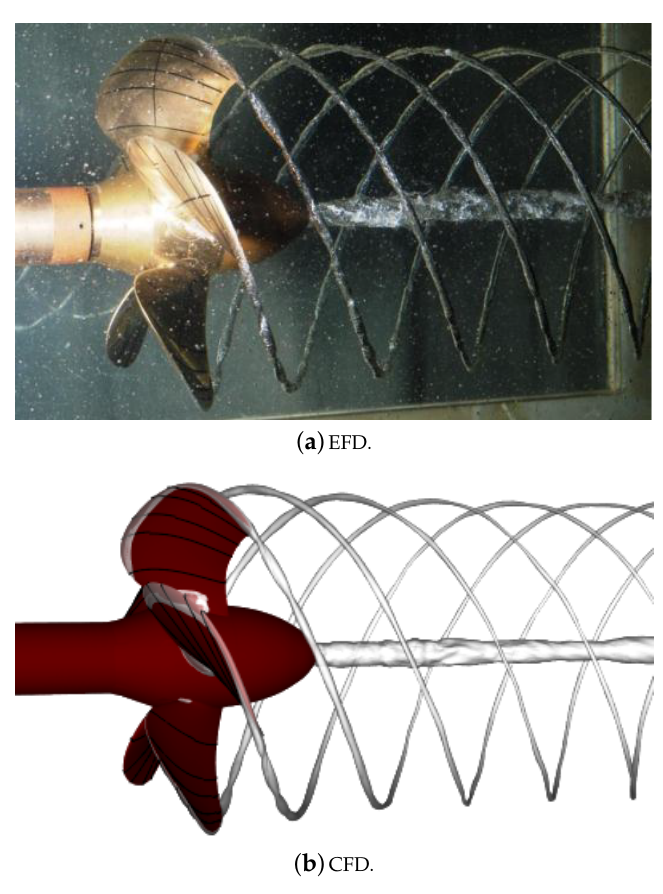
Figure 13. Comparison of the tip and hub vortex cavitation extents behind the propeller. The surface restricted streamlines and pressure coefficients, C p = 2 ( p − p ∞ ) / ( ρ ∞ n 2 D 2 ) , on the blade surface in wetted and cavitating conditions, are shown in Figure 14. The boundary layer flow was mostly circumferentially directed along the blade. The effect of cavitation on the surface restricted streamlines was significant. The re-entrant jets were directed towards the cavitating tip vortex at the closure line of the sheet cavitation, cf. Refs. [25,49]. In addition, flow separation was visible in the blade root region at cavitating conditions, caused by the blade root cavitation. Furthermore, the wetted case computation predicted a more radially extended although relatively fine separation region at the trailing edge of the